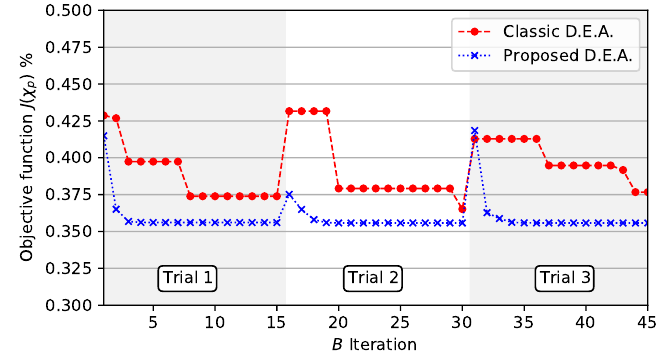
Figure 10. J ( χ p ) % progression for the KC200GT